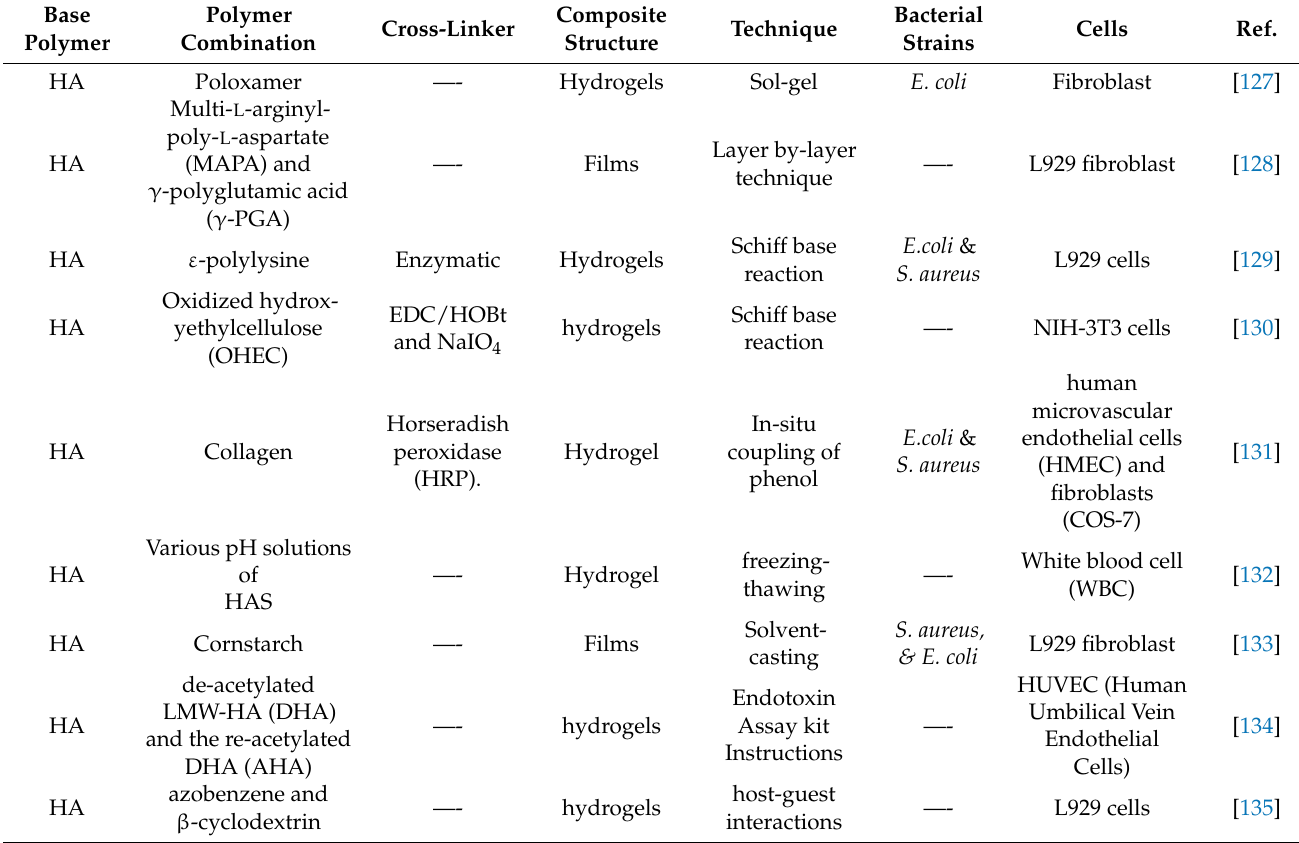
Table 5. HA combined with other polymers for wound healing